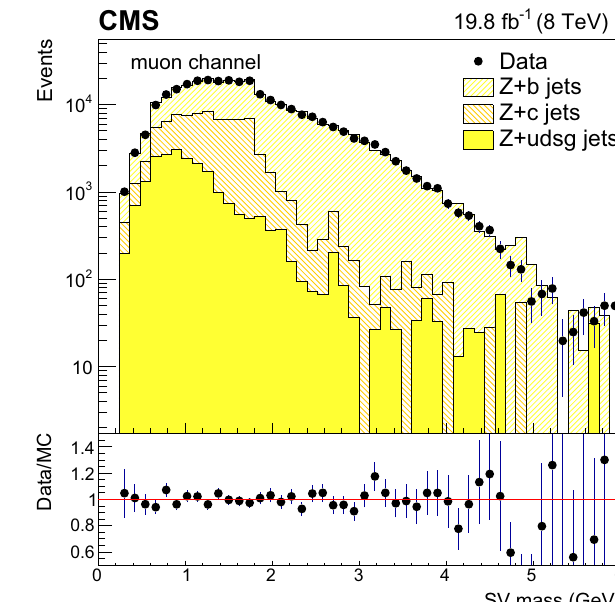
Fig. 3 Distributions of the secondary vertex (SV) mass of the leading jet after the Z ( 1b ) selection with the Z boson decaying into electrons ( left ) and muons ( right ). The subsamples corresponding to b-tagged jets originatingfromb, c,andlight-flavour quarks orgluons areshown, with